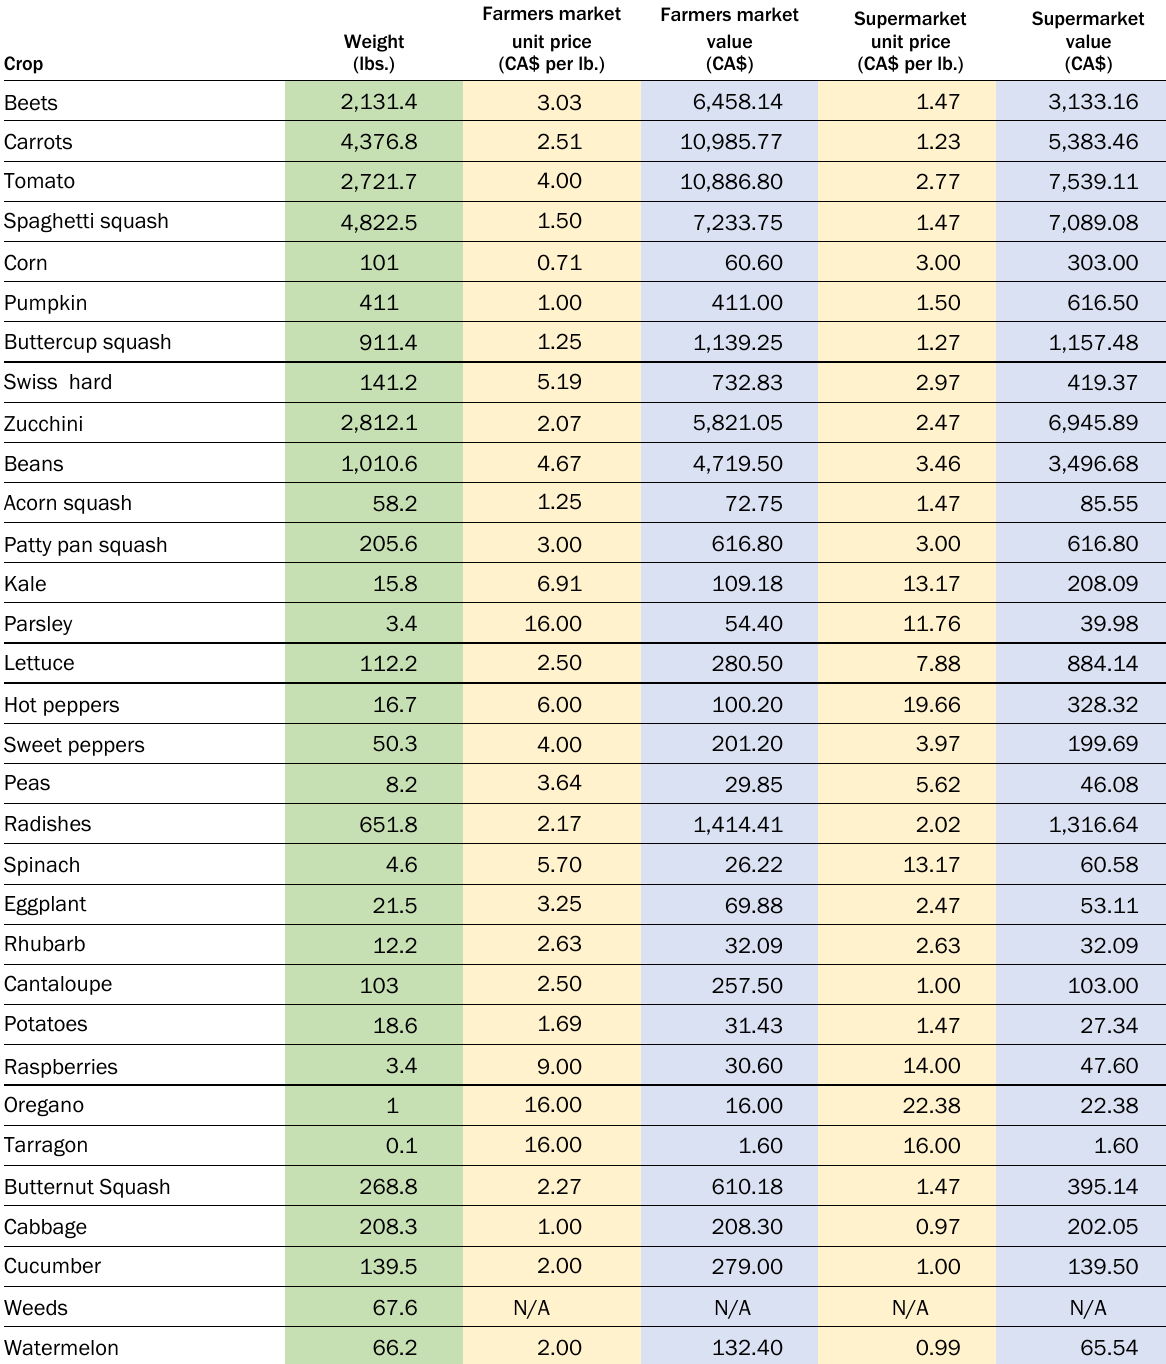
Table D1. Harvest Data for the Garden Patch,